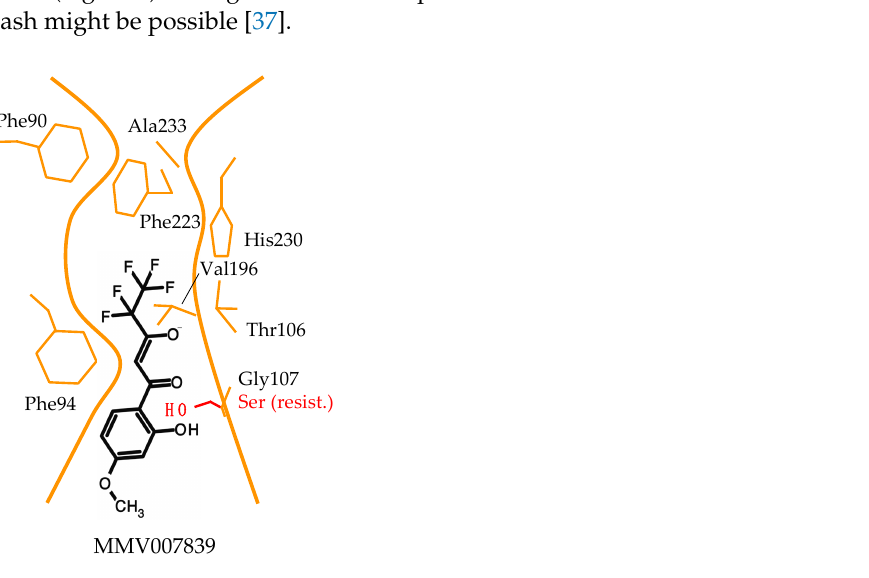
Figure 5. Model of the binding mode of MMV007839 to PfFNT. The inhibitor binds in the cytoplasmic vestibule and constriction region. The observed G107S resistance mutation produces a clash with the phenol hydroxyl of MMV007839.